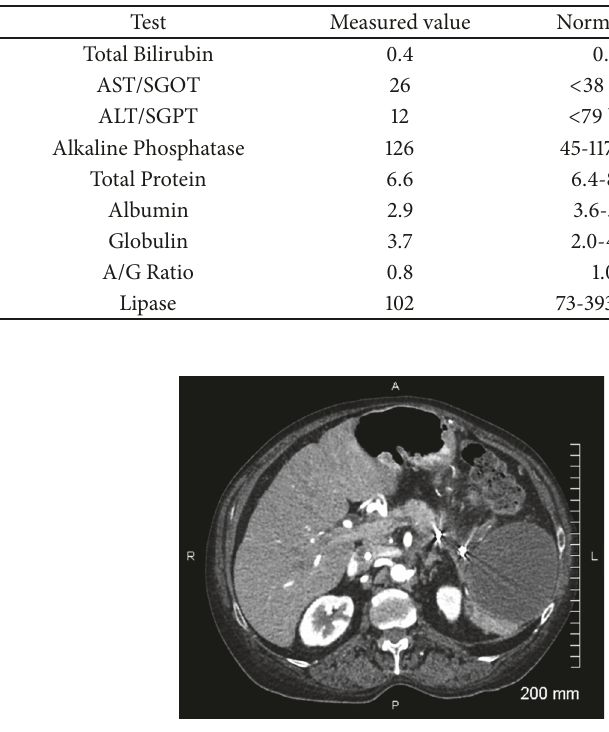
Figure 5: Post coil embolization angiogram with no bleeding.